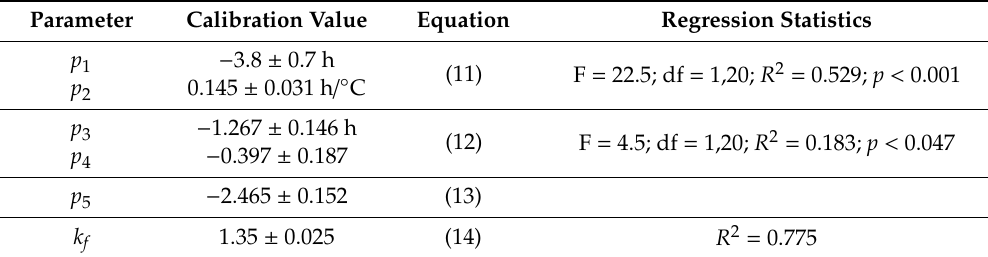
Figure 2. ( a ) Relationship between T 19h30 the temperature at 19h30 local DST and ∆ s the shift between the time at which 50% of migrating moths were observed and the time of sunset t s . Line is Equation (11). ( b ) Relationship between ∆ s and the shift between the first migrating moth and sunset ∆ 0 . Line is Equation (12). ( c ) Relationship between ∆ 0 and the observed duration of the moth migration period ∆ f . Line is Equation (13). ( d ) Optimization (maximum R 2 ) of the value of parameter k f in Equation (14). The value k f = 1.35 yielded R 2 = 0.775 between observed and simulated cumulative proportion of moths emigrating over 22 evenings (see Figure 3). Table 1. Model parameter calibration and regression